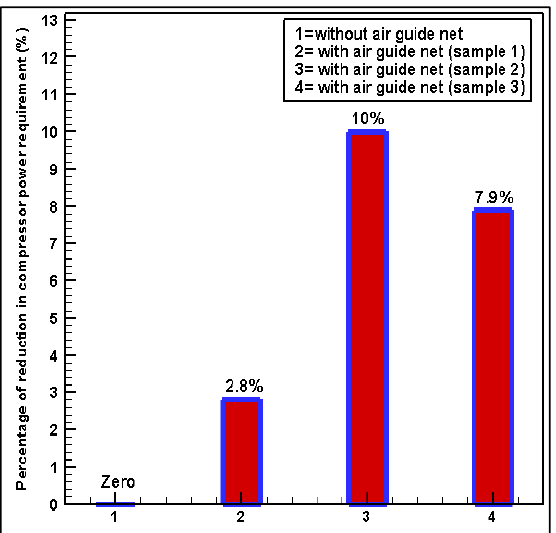
Fig. 10. Graphical representation of percentage of reduction in the compressor power